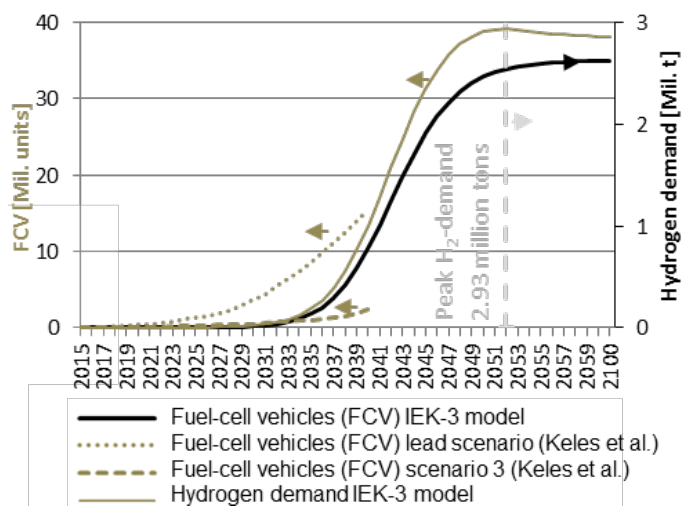
Figure 7. Number of fuel-cell vehicles in the IEK-3 model, in the Lead scenario and Scenario 3, according to Keles et al. [65] and annual consumption and peak demand for hydrogen.